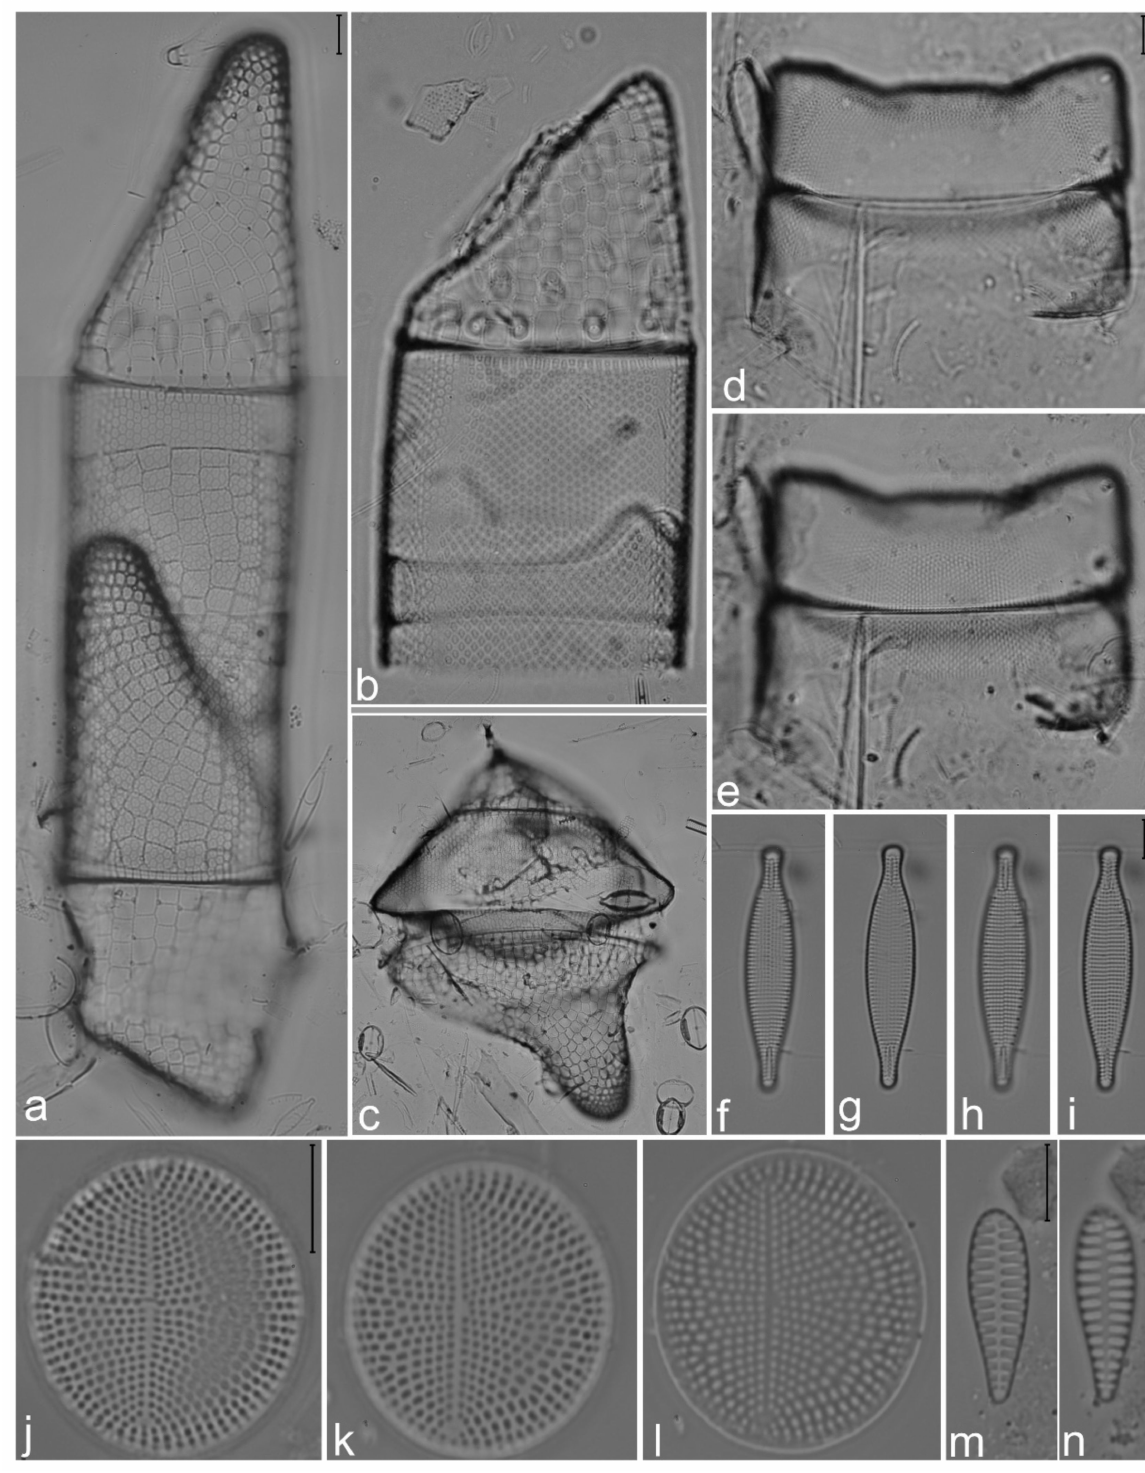
Figure 6. ( a – c ) Isthmia lindigiana images ( a , b ) and frustule showing the cingulum with full set of girdle bands ( c ); ( d , e ) Lampriscus shadboltianus ; ( f – i ) Talaroneis furcigera valves in different focal views; ( j – l ) Anorthoneis excentrica valves in different focal views; ( m , n ) Opephora mutabilis in different focal views. Scale bar = 10 µ